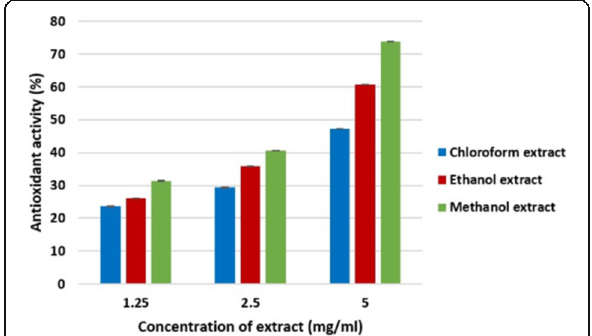
Fig. 4 Antioxidant activity of O. ferruginea leaves in different solvents